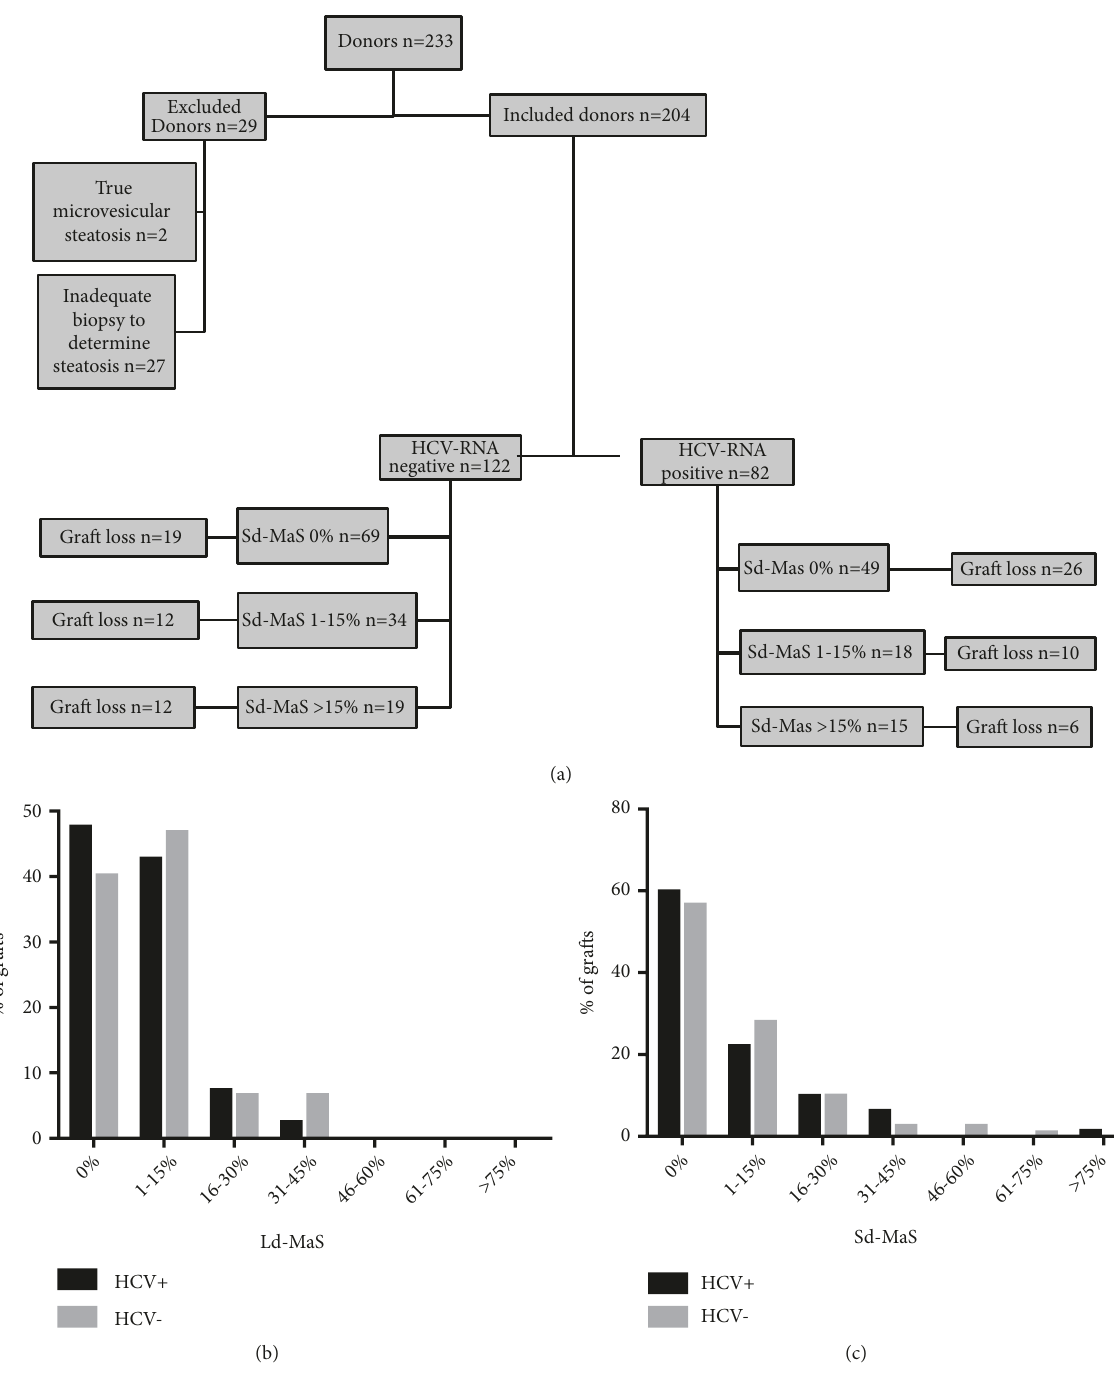
Figure 1: Study population. (a) Flow chart of liver graft loss according to HCV status and Sd-MaS percentage. (b) Graft Ld-MaS distribution in the HCV- and HCV+ groups. (c) Graft Sd-MaS distribution in the HCV- and HCV+ groups.